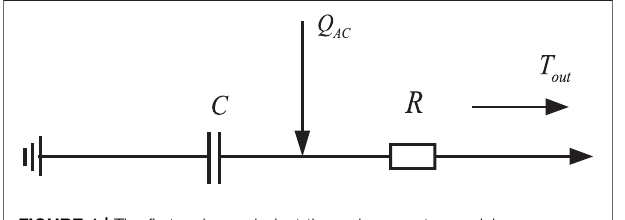
FIGURE 1 | The fi rst-order equivalent thermal parameter model.